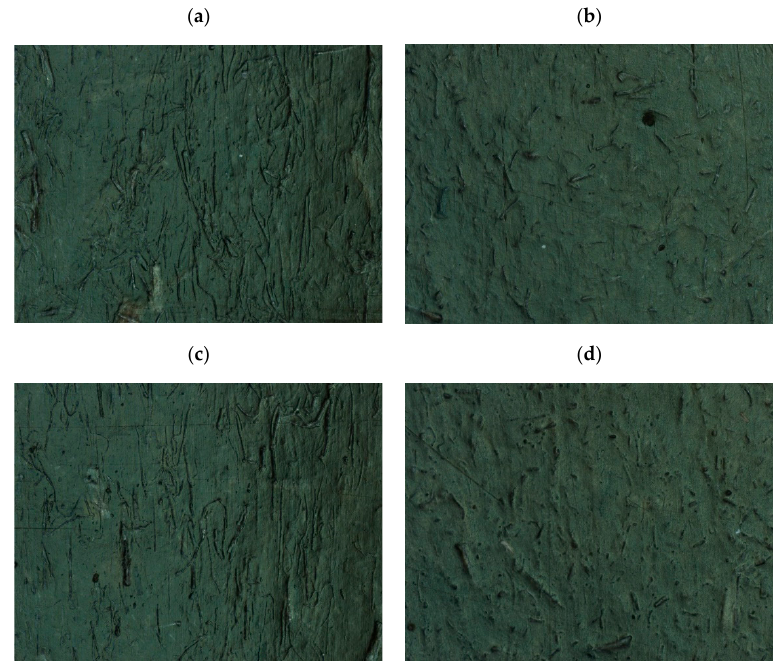
Figure 12. The photographs of fibers on the surface layer of PHBV biocomposite samples (magn. 50 × ): ( a ) H15SINGLE, ( b ) H15TWIN, ( c ) F15SINGLE, ( d )